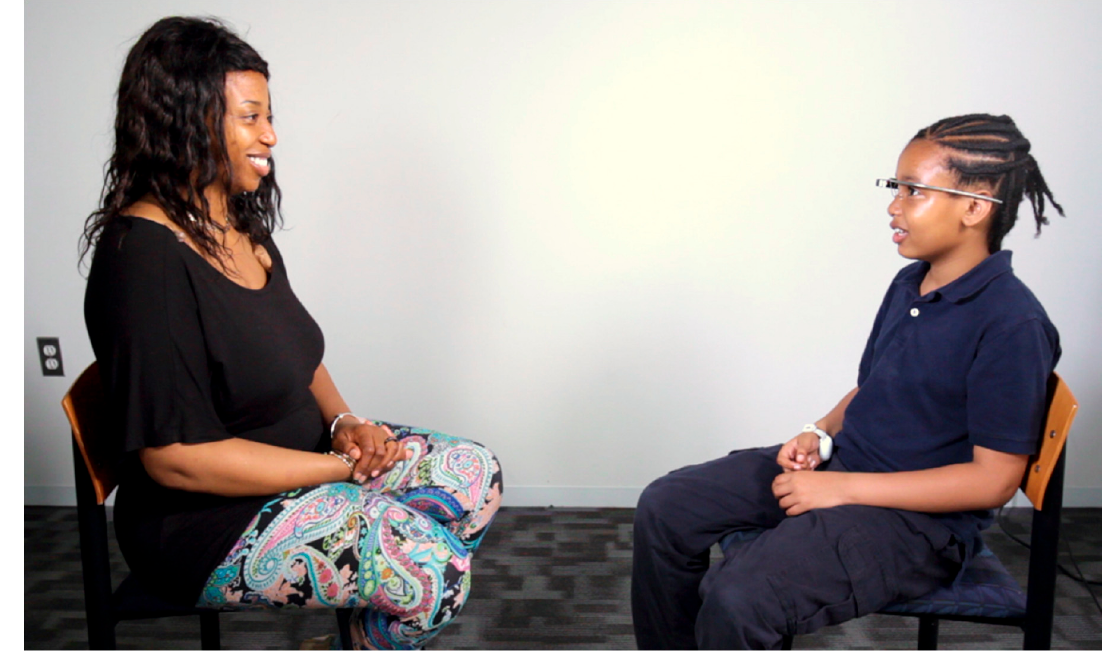
Figure 5. Empowered Brain User-Caregiver Setup. In each session, the participant and caregiver sit facing one another, promoting a ‘heads-up’ social interaction while trialing the apps. Written and informed consent has been obtained for the publication of these images from the depicted adult and from the parents/legal guardians of the minor.